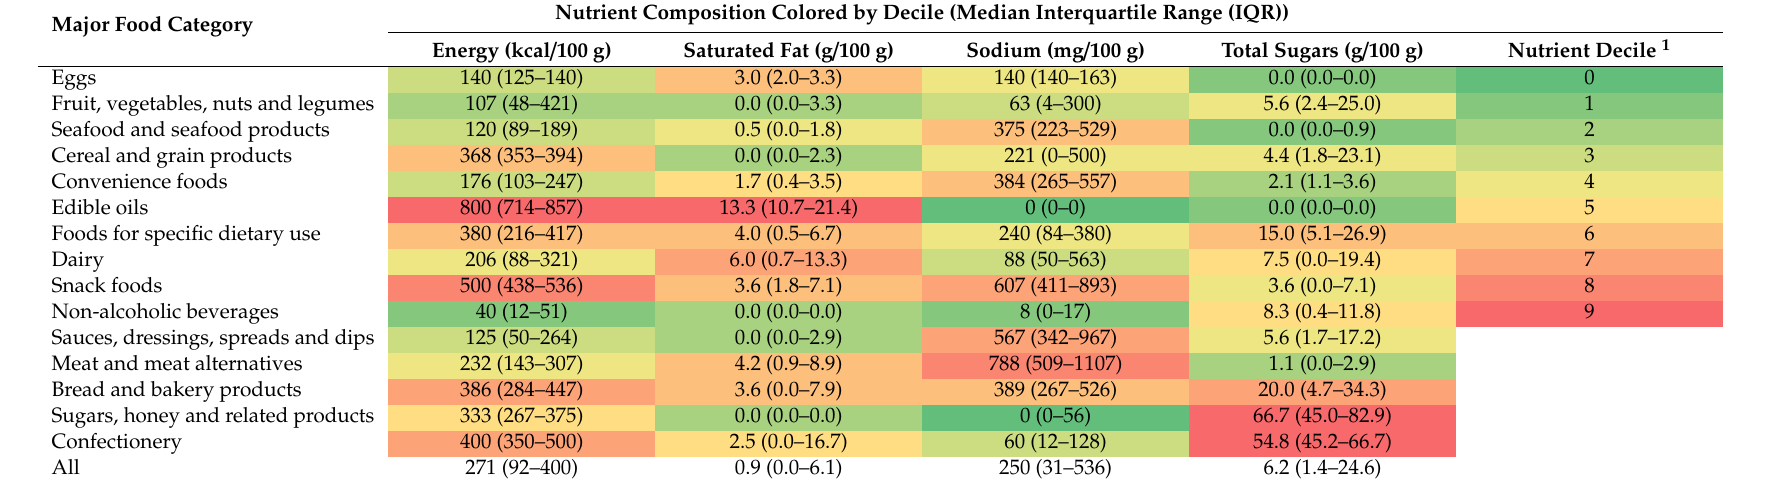
Table 2. Deciles of energy, saturated fat, sodium, and total sugars by major category in the US food and beverage